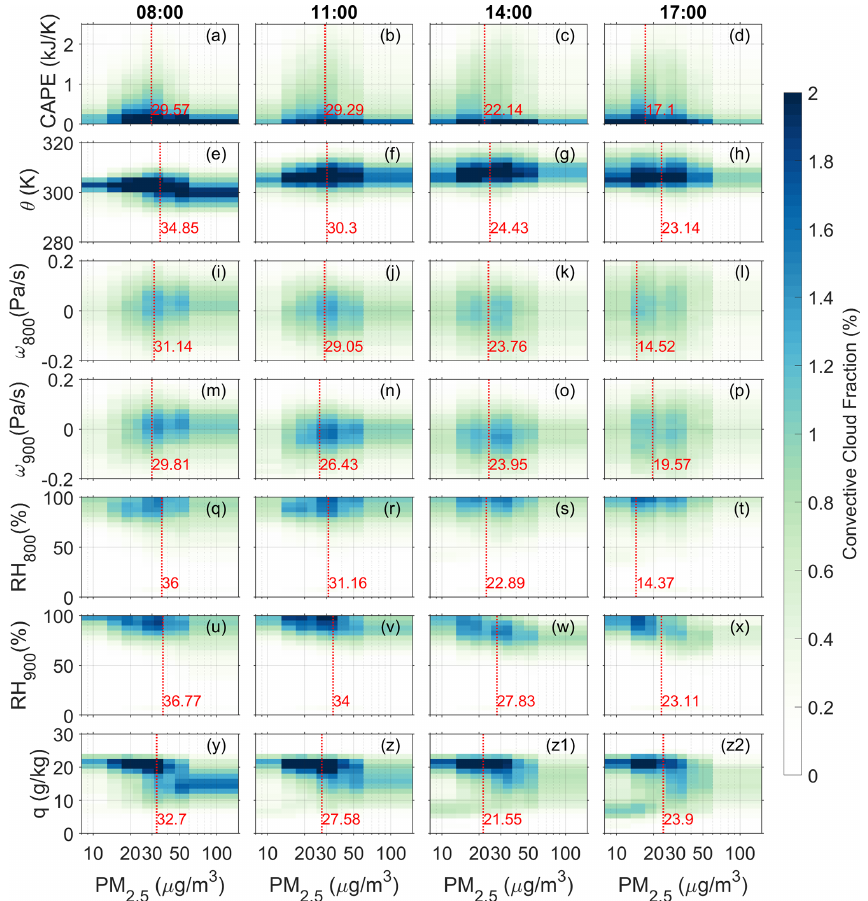
Figure 13. The joint distribution of convective cloud fraction (CCF) with respect to PM 2 . 5 concentration and (a–d) lower-tropospheric stability (LTS), (e–h) potential temperature ( θ ), (i–l) vertical pressure velocity at 800hPa ( ω 800 ) over terrain above 1000m, (m–p) vertical pressure velocity at 900hPa ( ω 900 ) over terrain below 1000m, (q–t) relative humidity at 800hPa (RH 800 ) over terrain above 1000m, (u– x) relative humidity at 900hPa (RH 900 ) over terrain below 1000m, and (z–y2) specific humidity at 2m (q) . Each column represents a different local time during the day within the ROI, specifically at 08:00, 11:00, 14:00, and 17:00. Dashed red lines and the numbers beside them mark the mean tipping points of CCF at different thermodynamic, dynamical, and humidity levels. Note that the x axis is in log